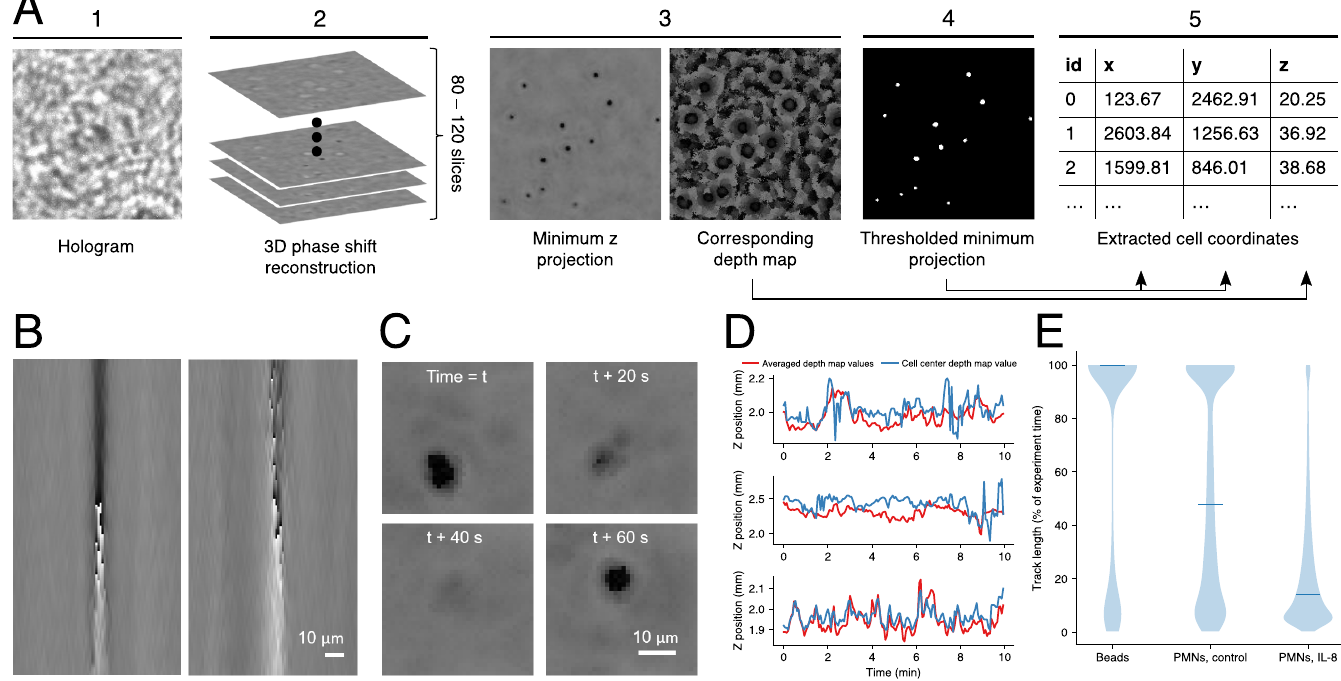
Fig 2. Determination of cell positions and tracking accuracy. (A) Cell coordinate extraction scheme (see text). (B) Phase-shift side(xz)-view of ⌀ 15 μ m polystyrene beads in a collagen drop. The left image shows a bead that located near the rim of the drop and 1.7 μ m above the sensor, the one in the right image was closer to the center of the drop (where the collagen layer is thicker) and 2.3 μ m above the sensor. The field of view shown is 168 x 90 μ m (height x width). (C) Phase shift minimum projections of one neutrophil granulocyte at four different time points, each 20 seconds apart, showcasing how the highly flexible morphology of this cell type can make it difficult to detect. (D) Z positions of three different cells, migrating towards an IL-8 gradient for 10 minutes. Two methods for determining individual z-coordinates are compared: averaging the z-coordinates of all cell pixels in the phase shift minimum projection (red graphs), and taking the z-coordinate of only the center pixel— rounded from the xy-centroid which is assumed as the cell position for tracking—as the z-position of the cell (blue graphs). (E) Distribution of track lengths for different tracking tasks. Blue lines represent respective mean track length. Left: Polystyrene beads are nearly static in the collagen and easily tracked throughout the whole time- lapse sequence (n = 3 independent experiments). Middle: Even without chemoattractant, some cells do move and also show a less consistent phase jump than beads, resulting in an average track length of half of the experiment time (n = 7). Right: Under the influence of 100 ng/ml IL-8 in the surrounding medium, most cells are moving fast; frequent collisions and changes in morphology lead to a lower average track length of about one sixth of the experiment time (n = 10).